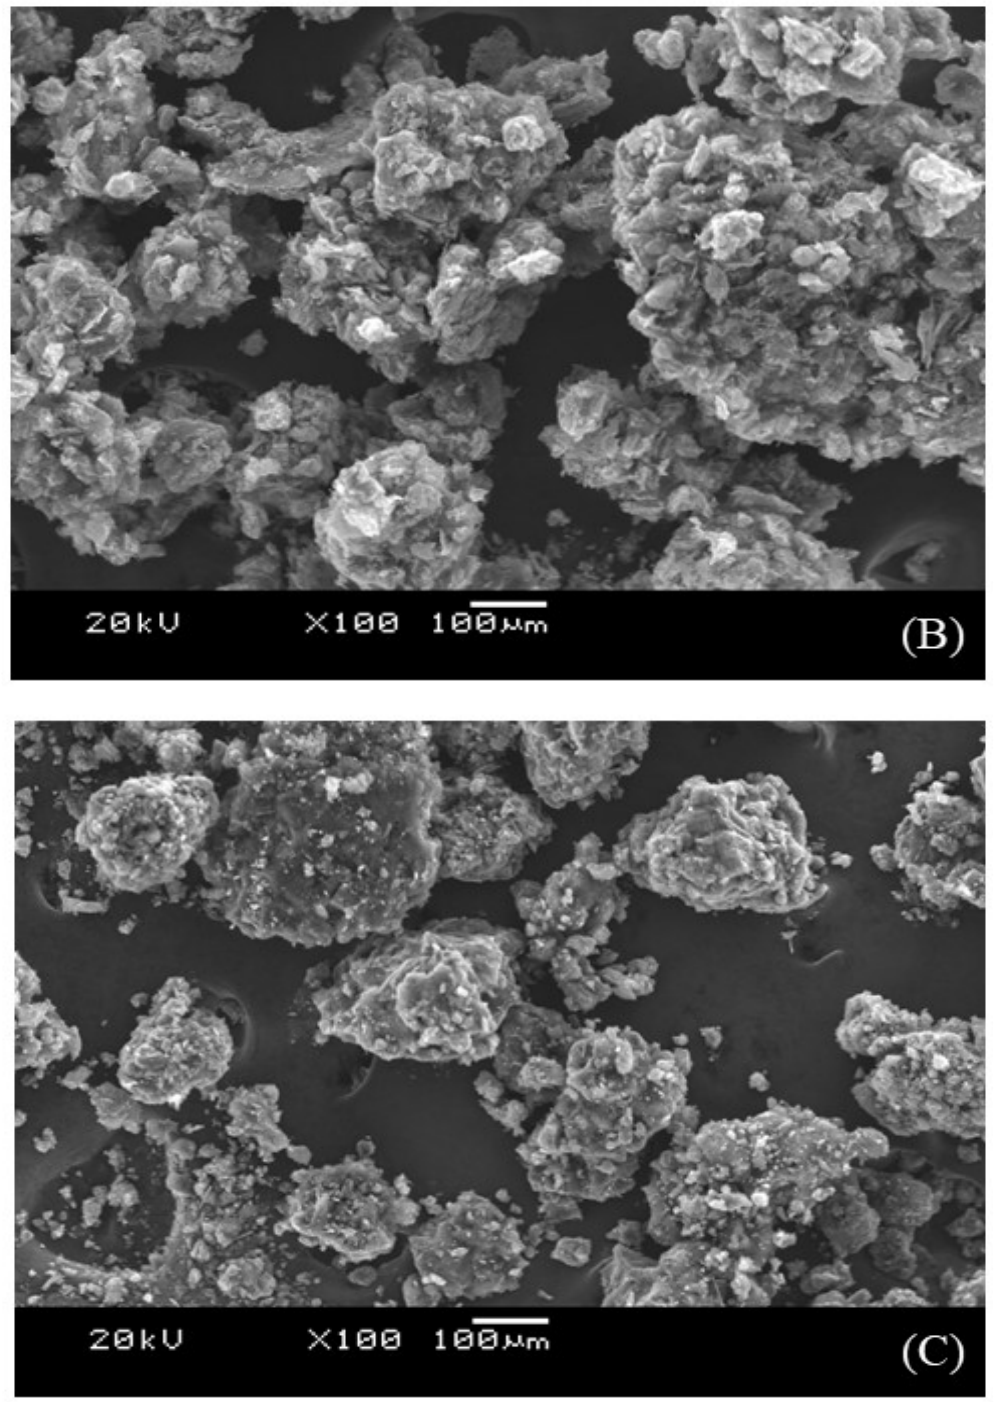
Figure 8. SEM images of ( A ) fresh catalyst, ( B ) used catalyst at 1 bar, ( C ) used catalyst at 7 bar.